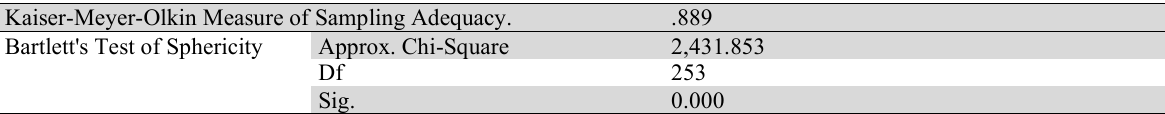
KMO and Bartlett's Test